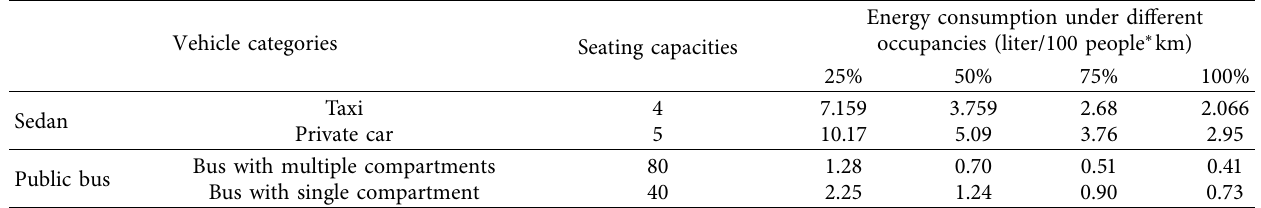
Table 5: Energy consumption comparison of different types of vehicles with different occupancies.